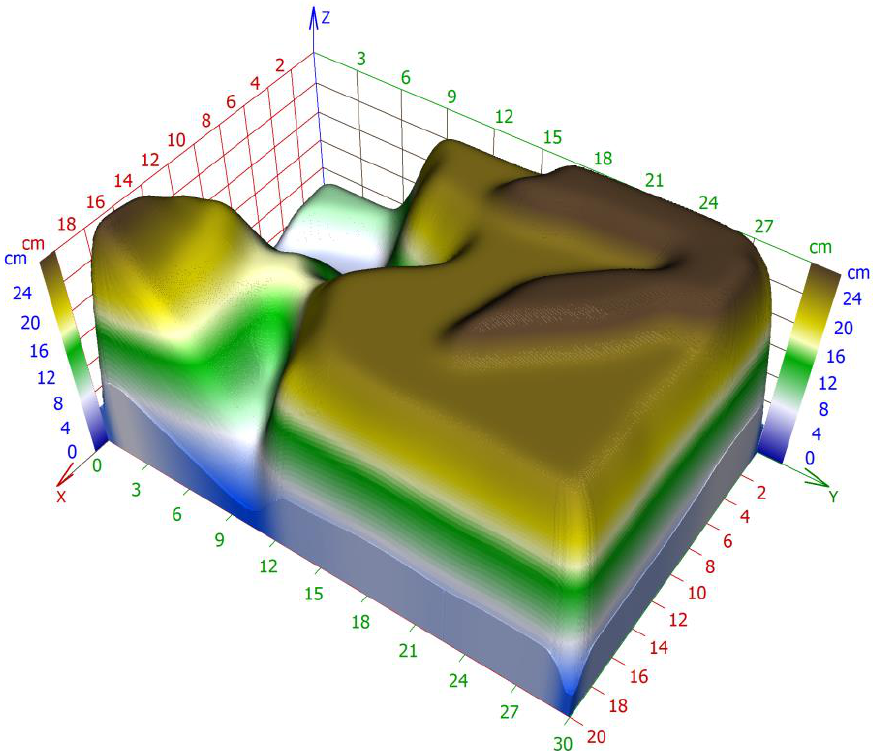
Figure 14. A 3D echelon approximation of the limestone sample by the optical cuts used in Figure 13 smoothed by 3D low-pass filters. The software was written by the first author. Taken from [45].